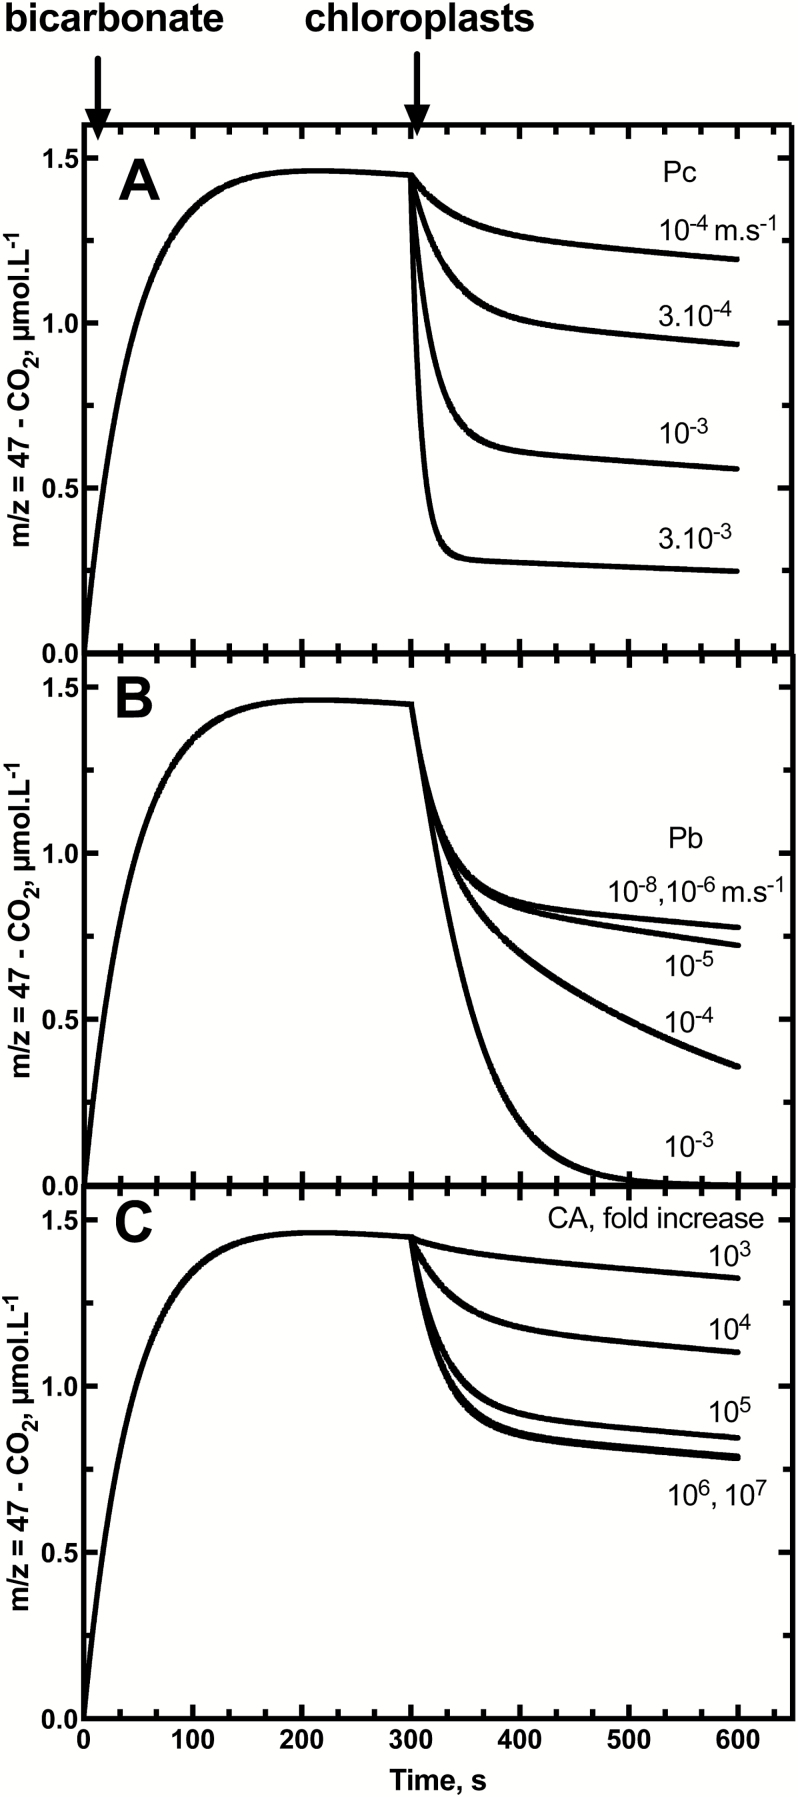
The modelled effects of variation in chloroplast envelope CO2 permeability (PCO2; A), HCO3− permeability (HCO3−; B), and in internal chloroplast CA activity (C) on the decrease in 13C18O16O (m/z=47) species in the assay after the injection of chloroplasts. In (A) PCO2was varied from 10–4 m s–1 to 3 × 10–3 m s–1 (PCO2was fixed at 10–8 m s–1, CA at 107-fold increase). In (B) PHCO3−was varied from 10–8 m s–1 to 10–3 m s–1 (PCO2 was fixed at 5 × 10–4 m s–1, CA at 107-fold increase). In (C), CA activity was modelled as the fold increase in the interconversion between CO2 and HCO3− within the chloroplast stroma and was varied between a 103 and 107 increase in the hydration and dehydration rate constants (PCO2was fixed at 5 × 10–4 m s–1 and PHCO3− at 10–8 m s–1). The modelling procedures are described in the Materials and methods and supplementary information, based on the use of low 18O-enriched bicarbonate equilibrated against 1.2% [18O]water. Labelled bicarbonate is added at time zero (1 mmol l–1 total) and chloroplasts are added after 300 s of equilibration in the assay.